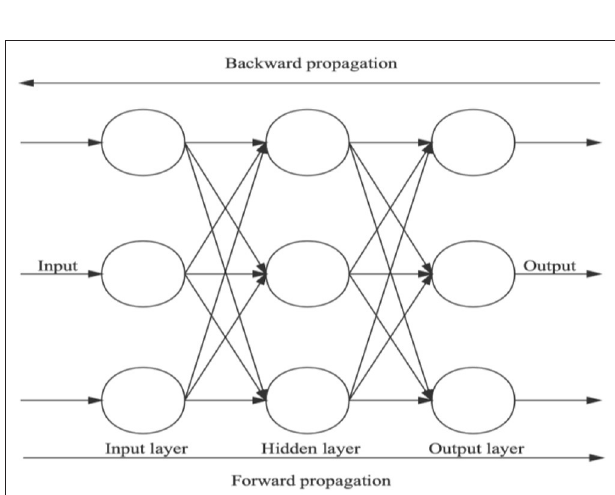
FIGURE 3 | Three-layer back propagation neural network topology [from Chen et al. (